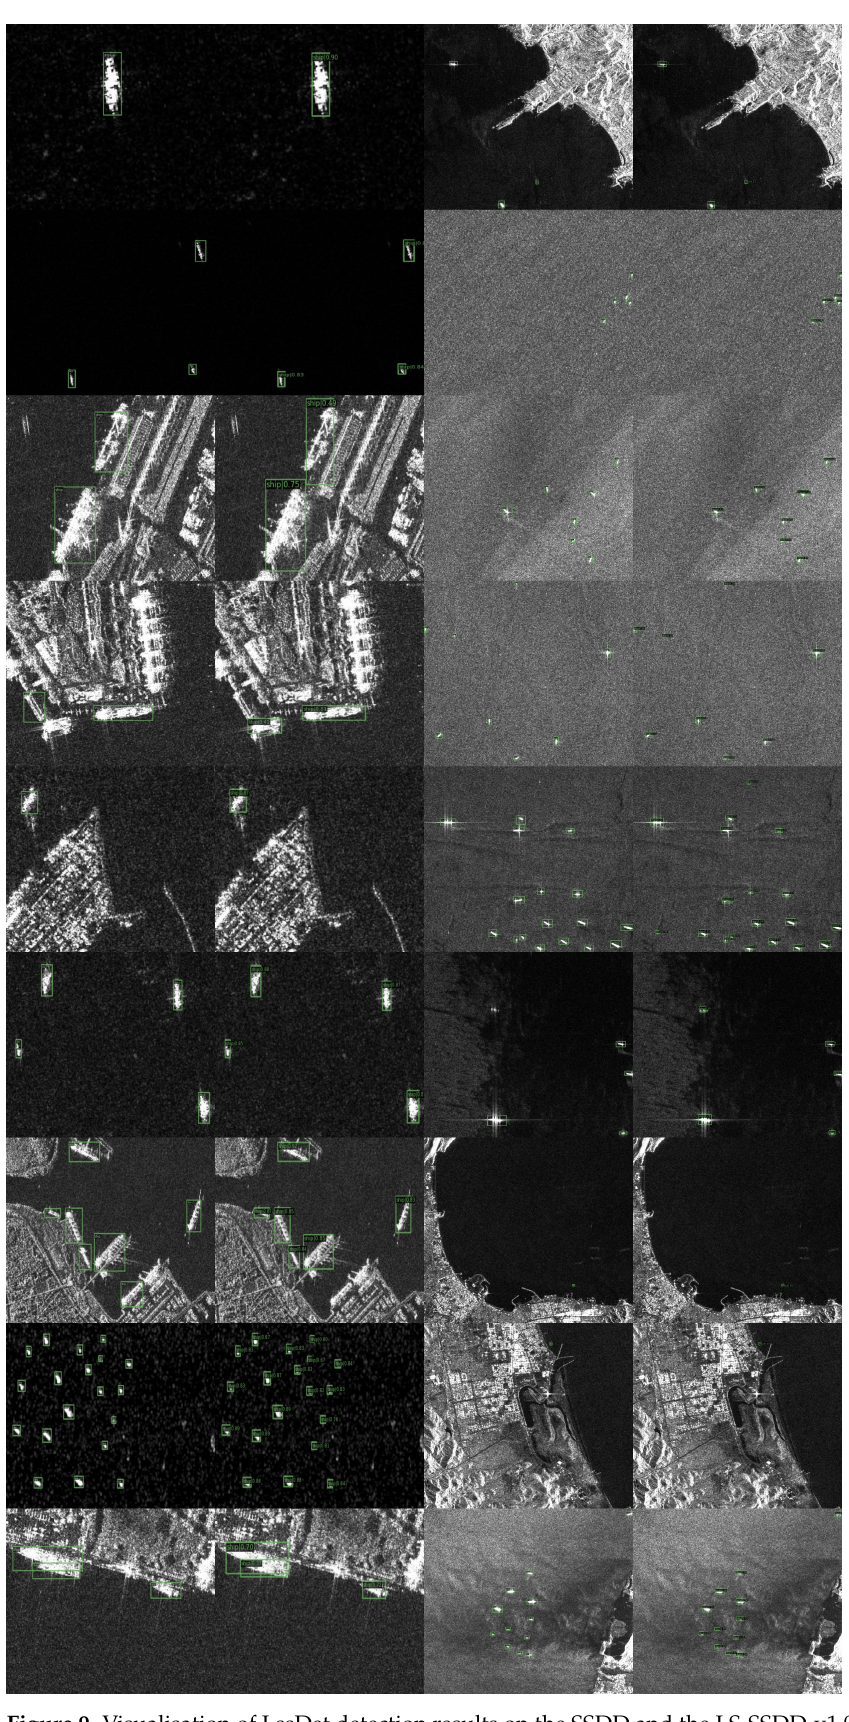
Figure 9. Visualisation of LssDet detection results on the SSDD and the